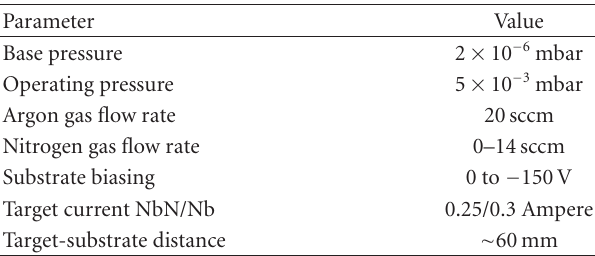
Table 1: Deposition parameters for Nb and NbN